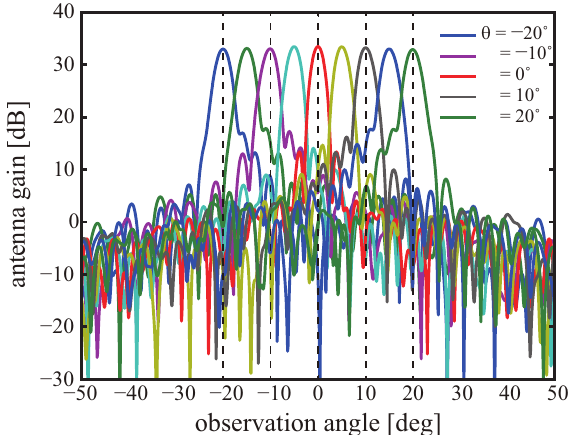
Figure 3. Simulated far-field patterns in H-plane of reconfigurable millimeter-wave reflectarray antennas when observation angles are changed from θ = − 20 ◦ to 20 ◦